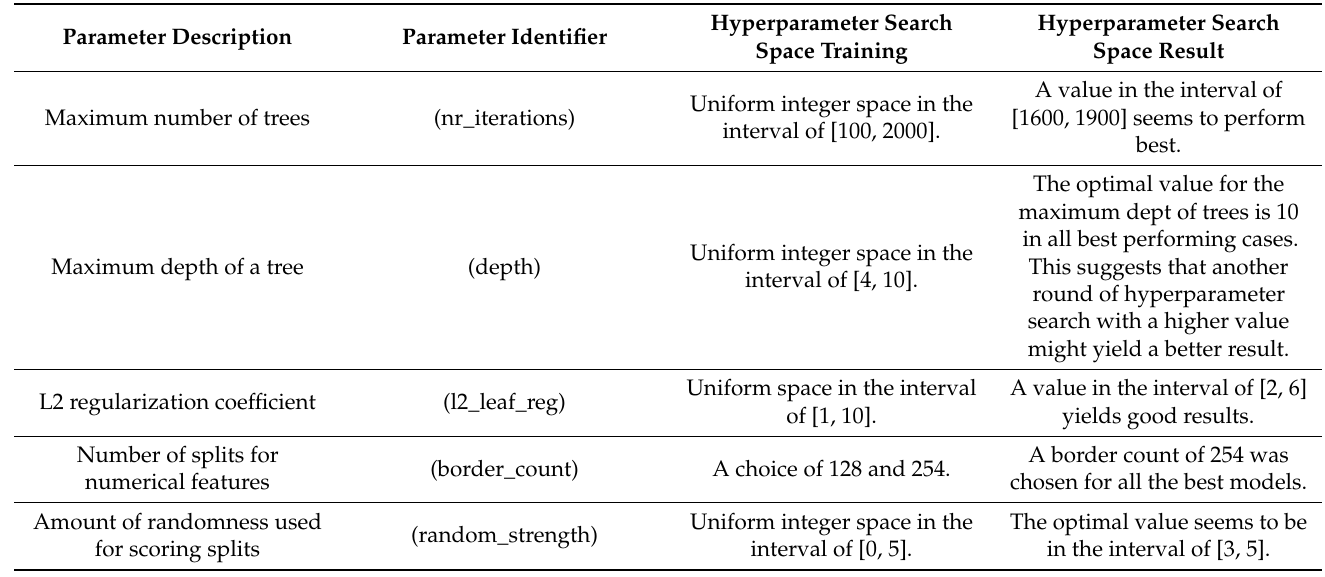
Table 8. Hyperparameter search space for gradient boosting machine.